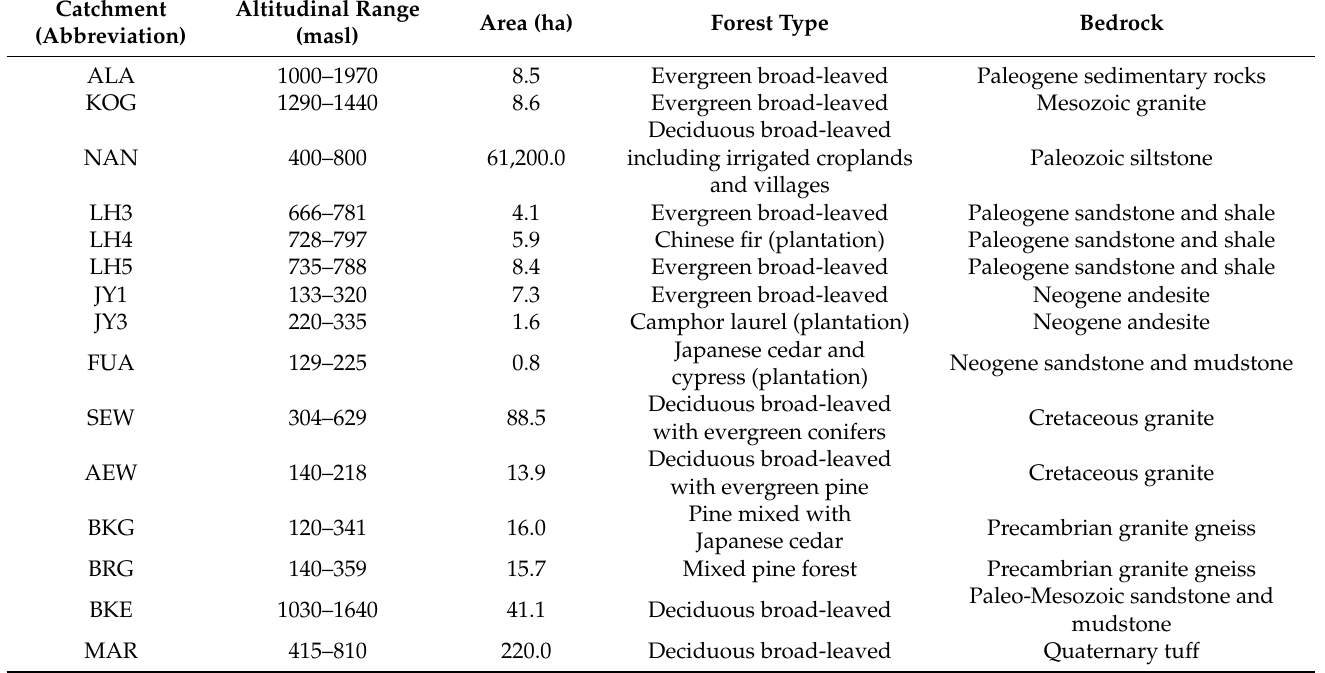
Table 2. Examined catchment